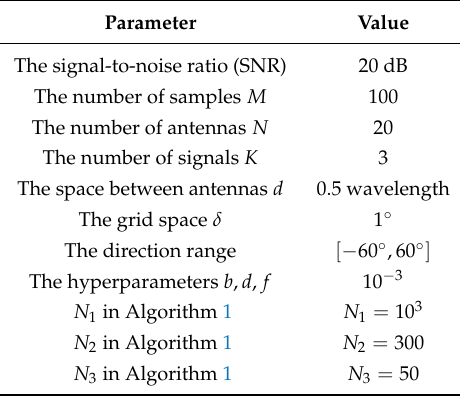
Table 1. Simulation